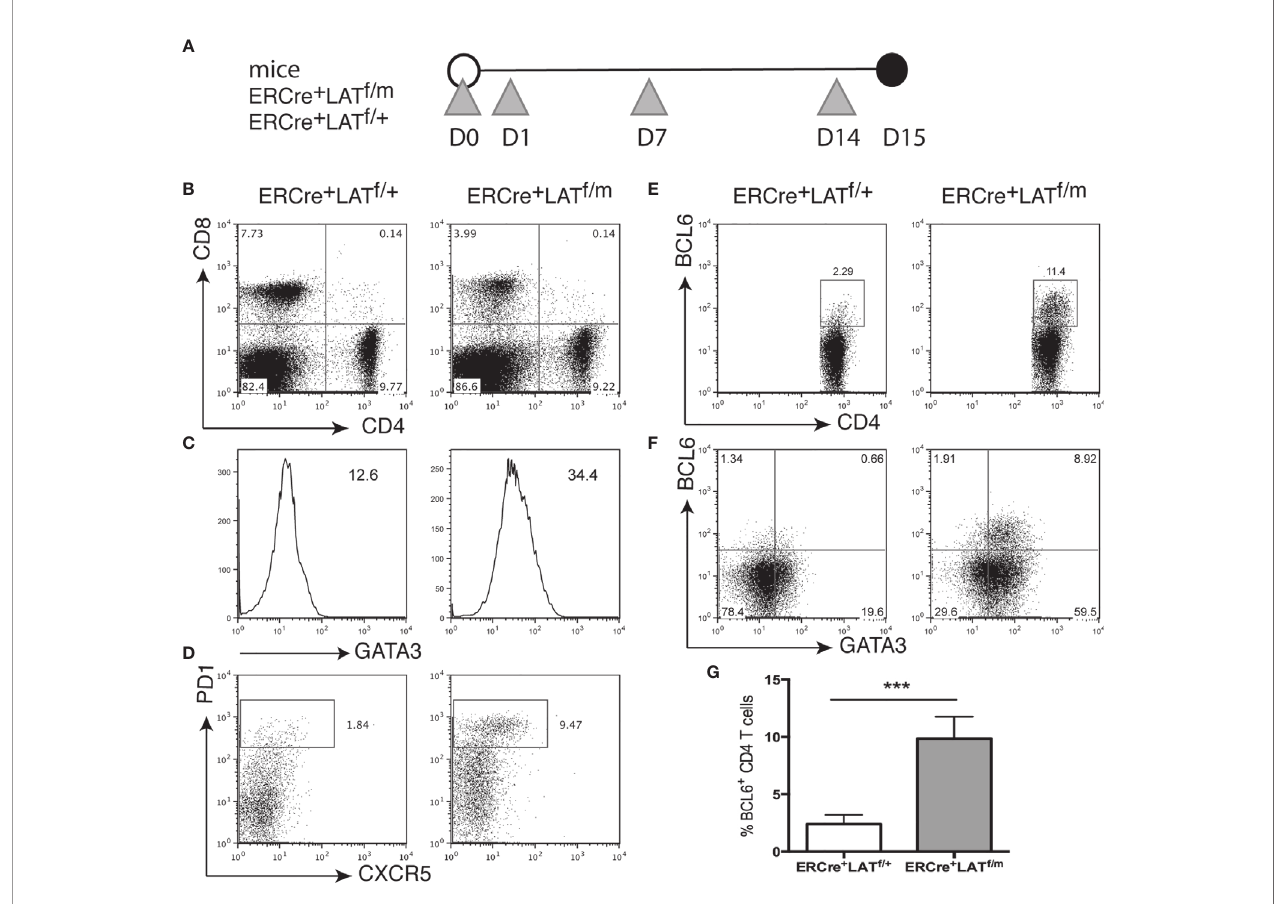
FIGURE 3 | Tfh differentiation in ERCre + LAT f/m mice. (A) ERCre + LAT f/+ and ERCre + LAT f/m mice were injected at day 0, 1, 7, and 14 with tamoxifen prior to being sacri fi ced on day 15. Grey triangles indicate the day of tamoxifen treatment. (B) CD4 and CD8 expression in the spleen. (C) Intracellular staining of GATA3 in CD4 + T cells. Numbers indicate gMFI. (D) Cells were pre-gated on CD4 + for CXCR5 vs. PD1 expression. (E) Intracellular staining of BCL6 in CD4 + T cells. (F) GATA3 and BCL6 expression in CD4 + T cells. (G) The percentage of CD4 + T cells expressing BCL6. Data are representative of 2 individual experiments. Two-tailed t test; ***p <